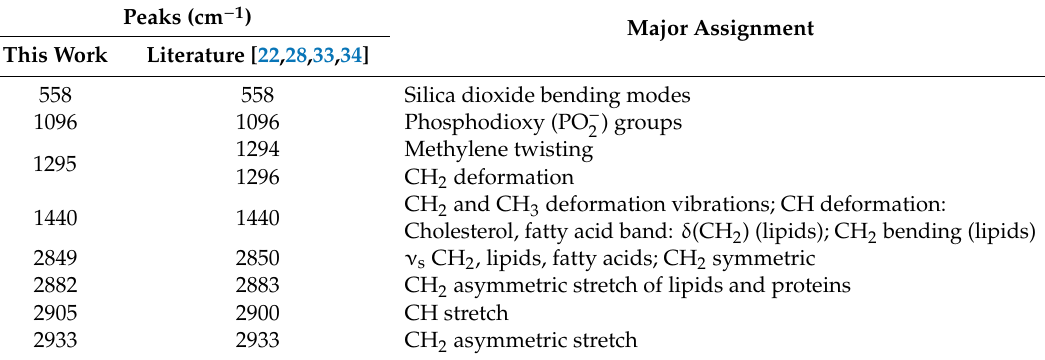
Table 5. Peak position and mode assignment of breast tissue of secretions area of benign mixed tumor (sample